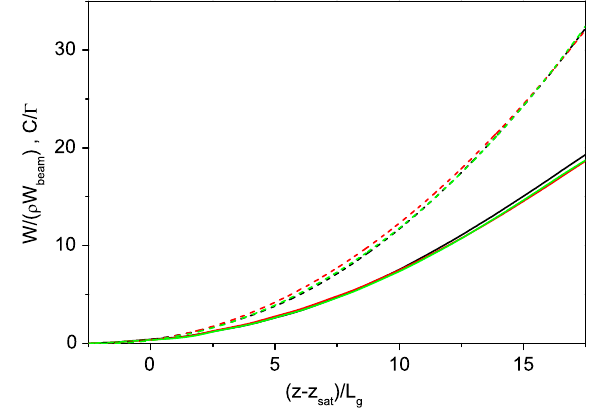
FIG. 7. Coefficients a (black line) and b (red line) of the rational fit of the tapering law (6).